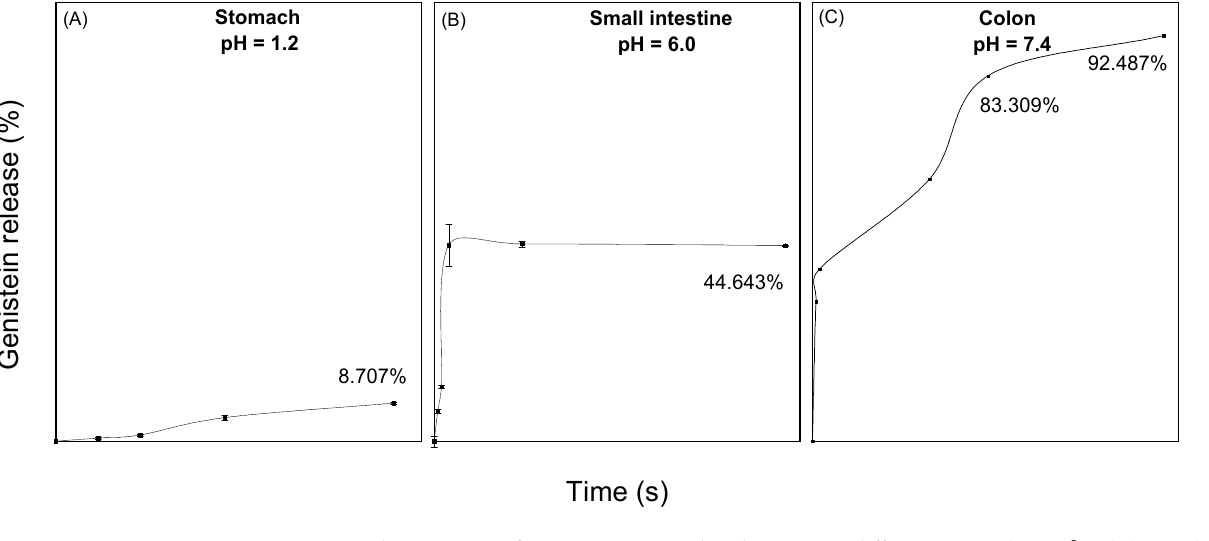
Table 1. Cytotoxic effect of genistein on HaCaT and SW480 cells.